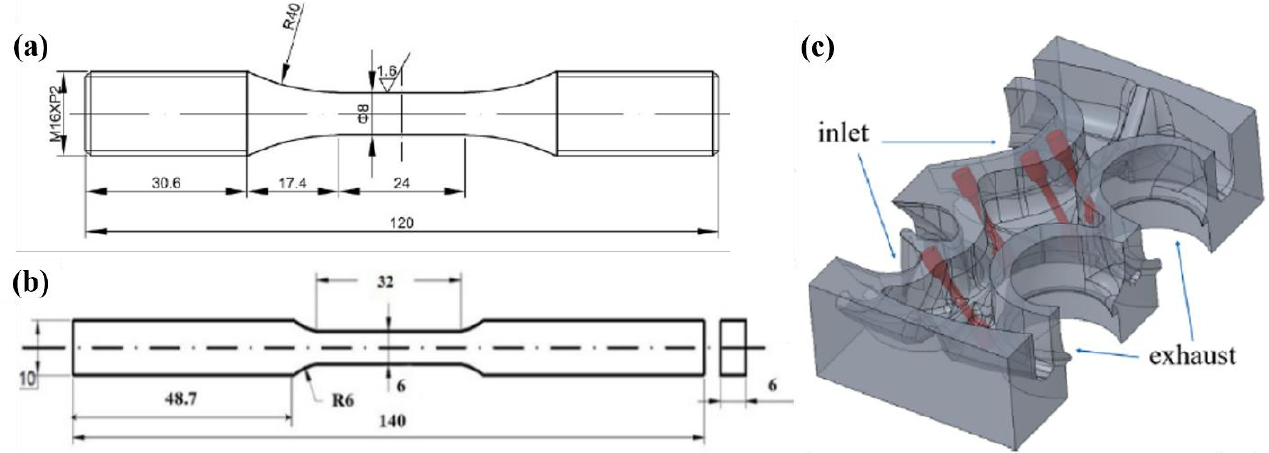
Figure 11. ( a ) A typical specimen for HCF testing [257]. ( b ) A typical specimen for LCF testing [86]. ( c ) Specimens extracted directly from cast cylinder heads [256]. Reproduced with permission from Elsevier and John Wiley and Sons.